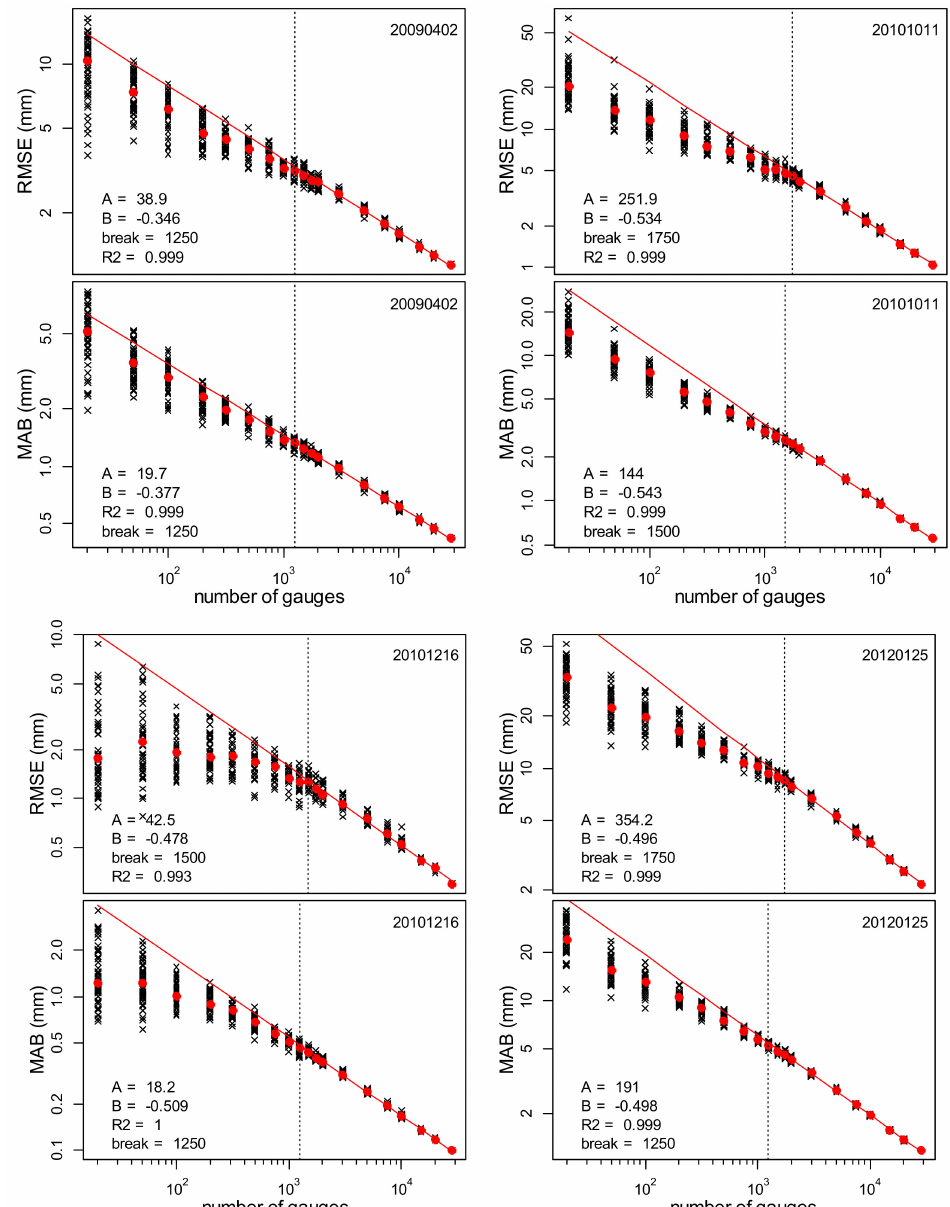
Figure 8. Variation of root-mean-square-error (RMSE) and mean-absolute-bias (MAB) with the number of gauges; the solid circles are the median for a given number of gauges and the straight lines are power law curves fitted to the higher number of gauges; A is the scaling constant; B is the scaling exponent; the vertical dashed lines are the breaking point of the power law scaling; R2 is the coe ffi cient of determination of the fit; y axis also on log10